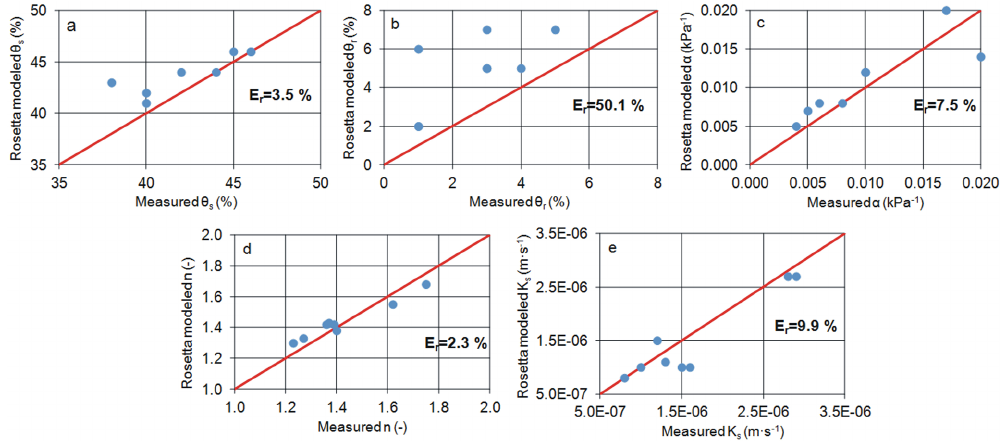
Figure 5. Comparison of measured and modelled parameters of Mualem and Van Genuchten models for some soil samples taken in the study area, obtained through Rosetta pedotransfer function: (a) θ s , (b) θ r , (c) α , (d) n , (e) K s